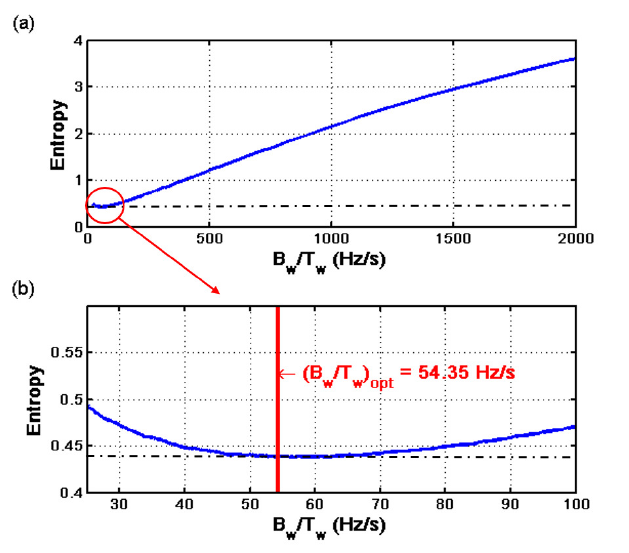
Figure 9. ( a ) Entropy of the time-frequency analysis of the LSH using the Slepian window, as a function of the parameter B W / T W ; ( b ) zoomed area of the entropy in the interval close to the optimum value of B W / T W . The vertical line corresponds to the minimum entropy value, which coincides with the criteria of maximum overlapping between the Slepian window and the LSH, as proposed in this